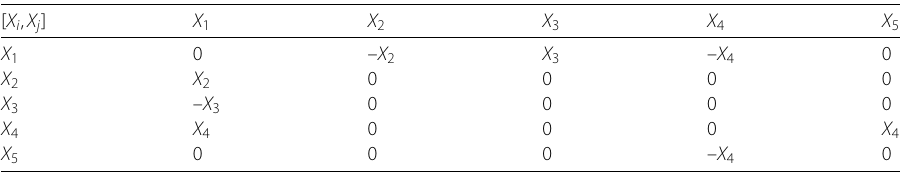
Table 1 Table of Lie brackets [ X i , X j ] X 1 X 2 X 3 X 4 X 5 X